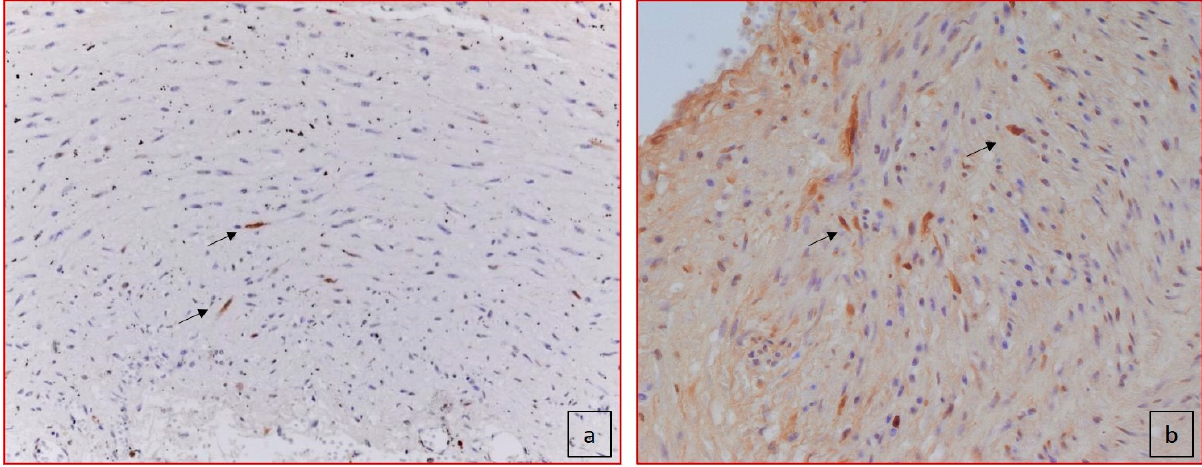
Figure 5. Apoptosis. Two different cases of TUNEL nuclear staining positivity for apoptosis of SMCs within the parietal wall (black arrows). ( a ) Case 2 (100×): apoptotic cells in the media without clear signs of proliferation; ( b ) case 4: diffuse apoptotic cells in the media (100×).